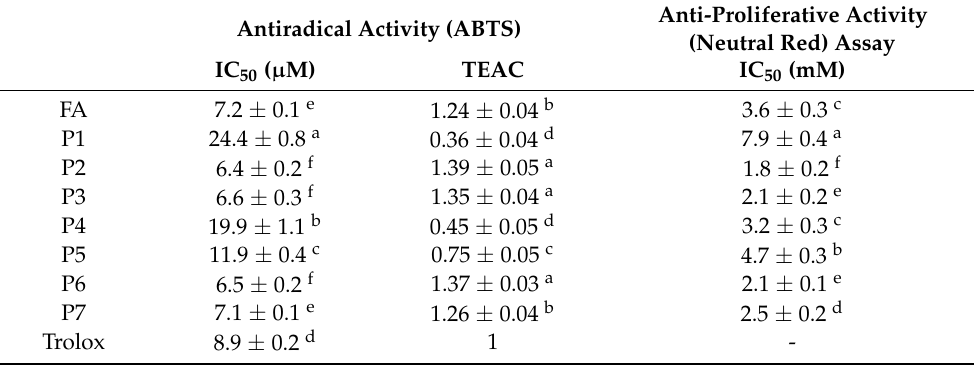
Table 4. Antiradical (IC 50 , TEAC coefficient) and anti-proliferative (IC 50 ) activities of FA and its oxidation